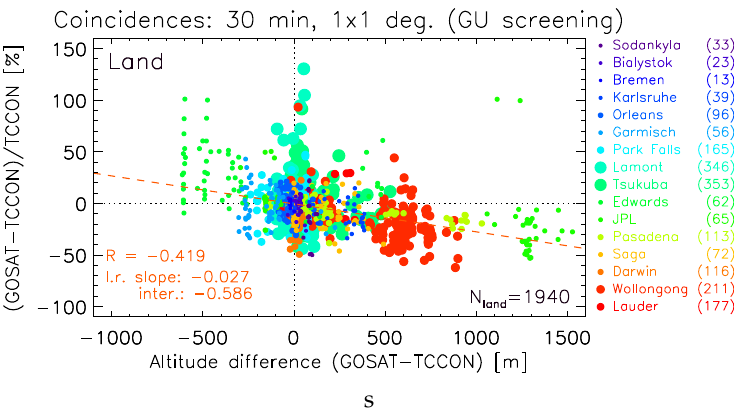
Figure 9. Correction of Figure 9 in [1]. Relative differences (GOSAT − TCCON)/TCCON as a function of the difference, in meters, between the retrieved altitude of the GOSAT footprints and the altitude of the TCCON sites, for GOSAT land scans only. The caption and color-coding are identical to those of Figure